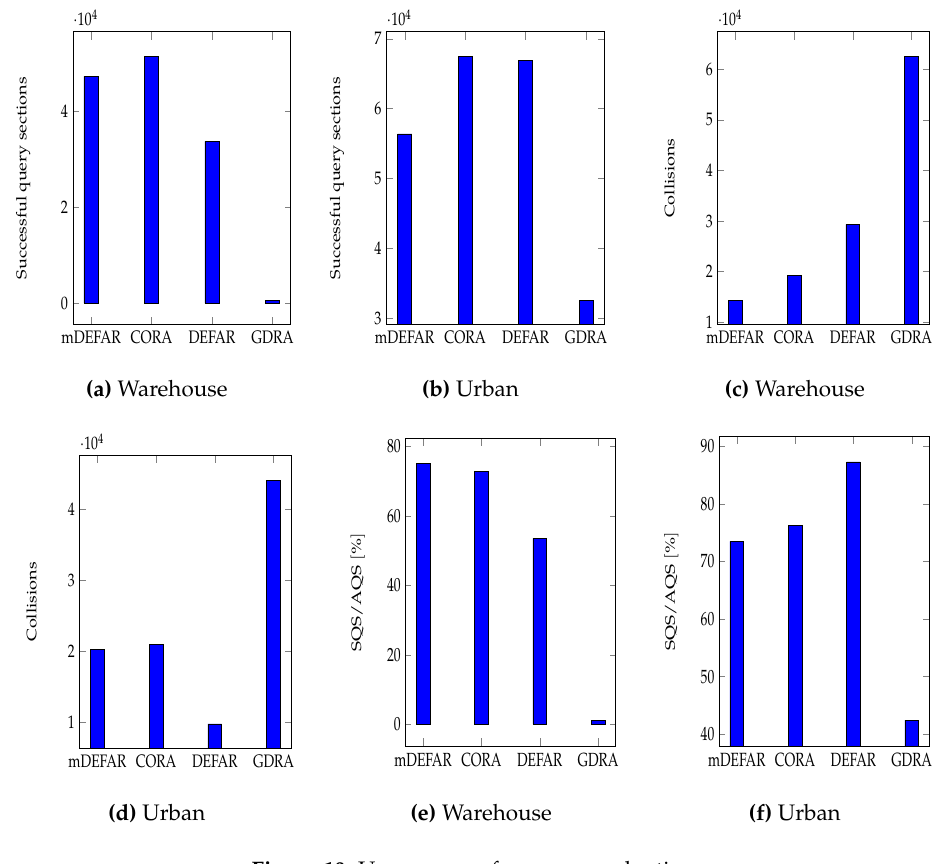
Figure 10. Use cases performance evaluation.